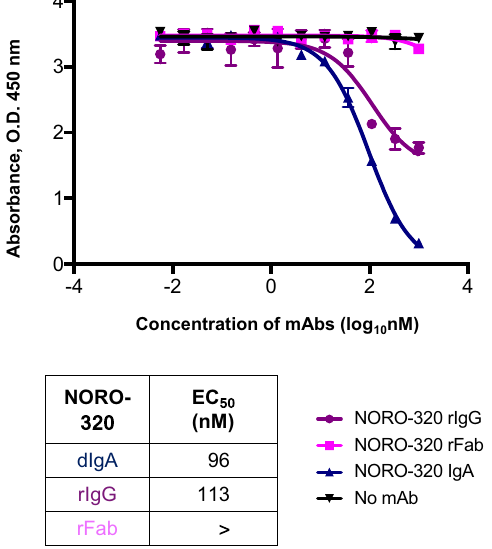
Fig. 4 HBGA blocking of GII.4 VLPs by NORO-320 is a result of steric hindrance. NORO-320 was expressed recombinantly as Fab (rFab) or IgG (rIgG) forms and puri fi ed. GII.4 VLPs were preincubated with either NORO- 320 rFab, rIgG or the original hybridoma-secreted (Hyb) dimeric IgA and added to wells that had been coated previously with PGM. Half-maximal concentrations (EC 50 ) for the three antibodies tested are listed. The > symbol indicates blocking EC 50 value was greater than 1000 Mn. Data presented are means ± SE, n = 2 independent study replicates and from one of two independent experiments with similar results. Source Data are